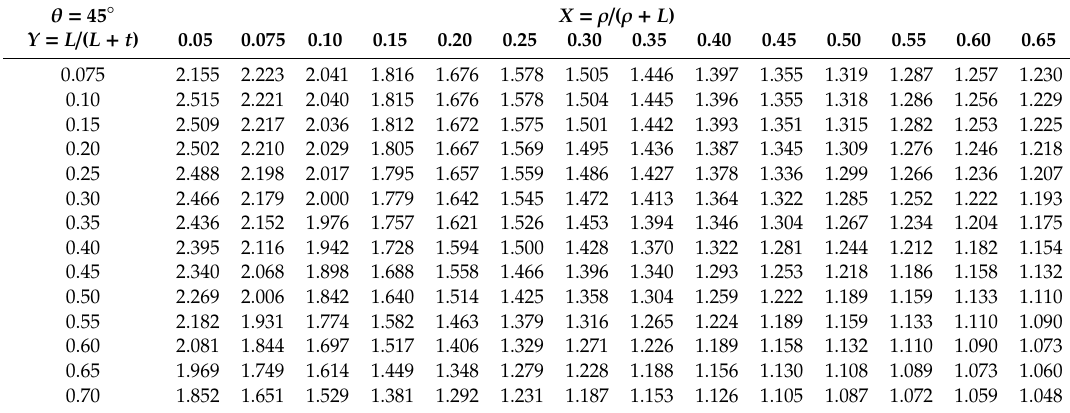
Table 1. Representation of SCF values for a Single-V butt joint subjected to tensile loading. θ = 45 ◦ X = ρ / ( ρ + L ) Y = L / ( L + t